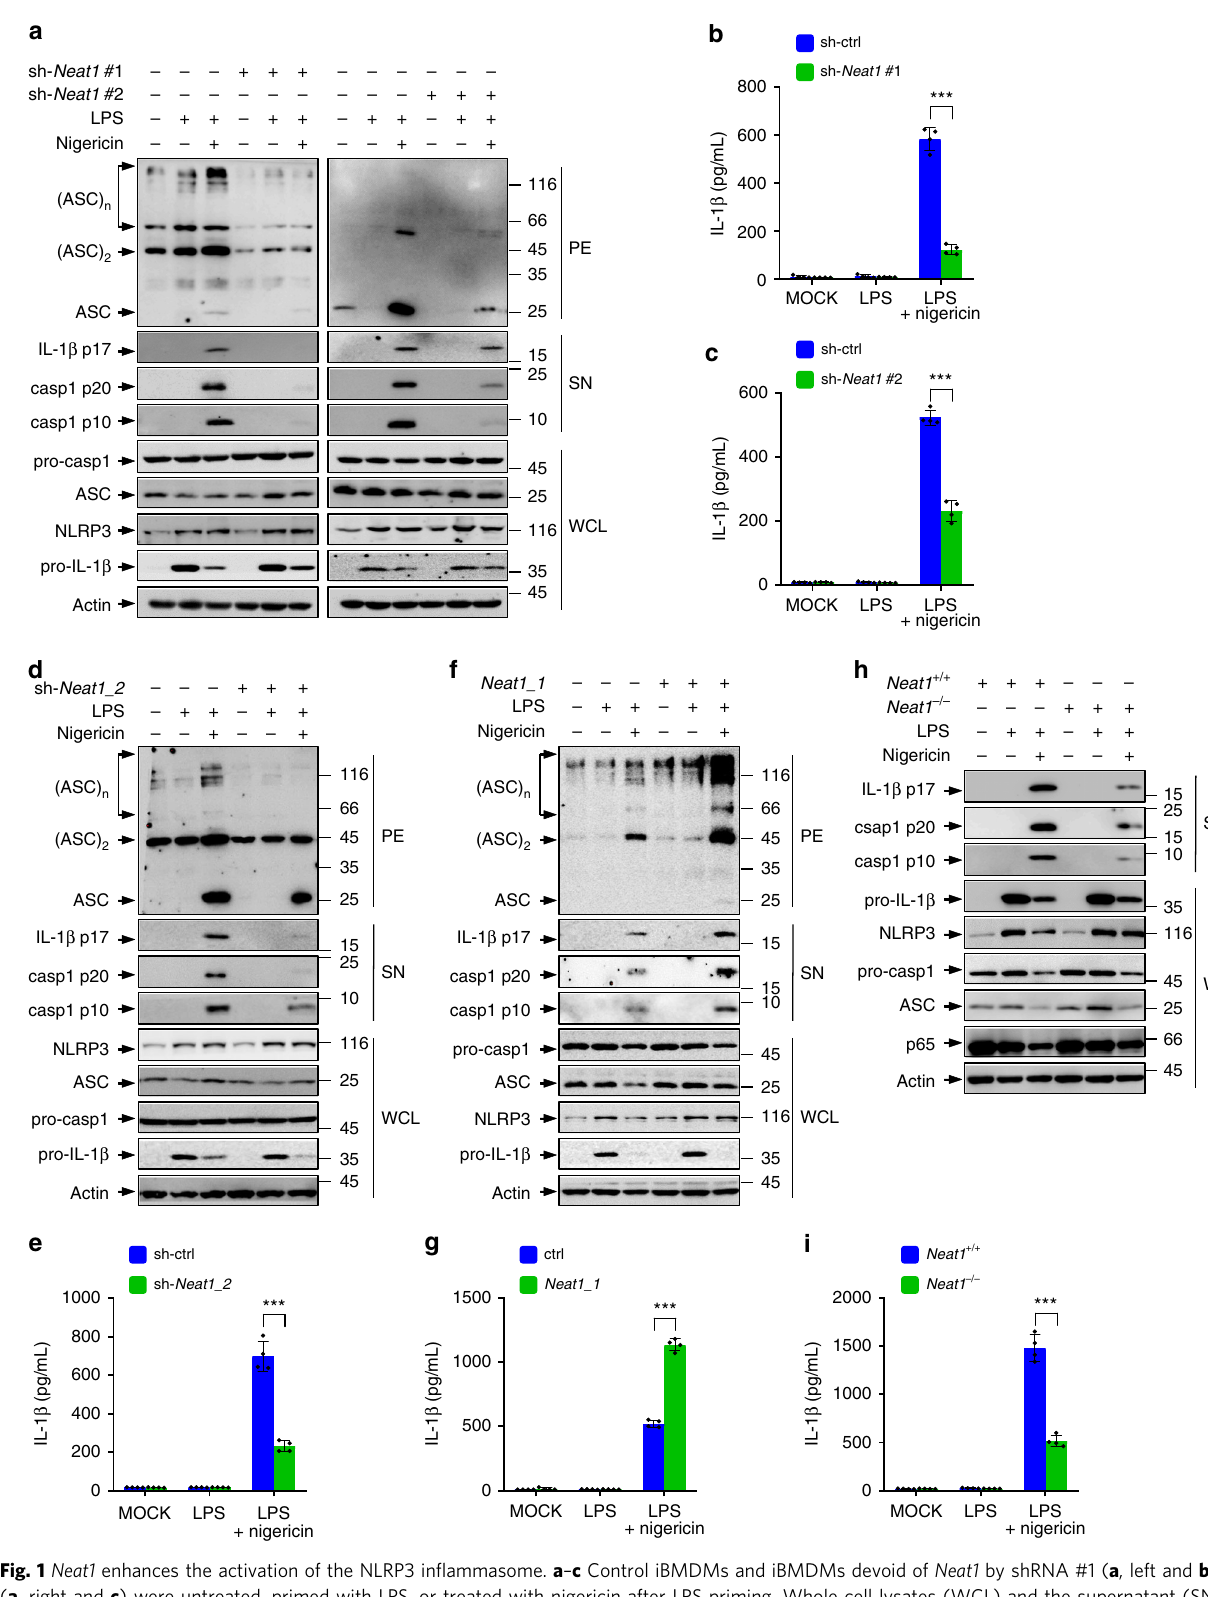
Fig. 1 Neat1 enhances the activation of the NLRP3 in fl ammasome. a – c Control iBMDMs and iBMDMs devoid of Neat1 by shRNA #1 ( a , left and b ) or #2 ( a , right and c ) were untreated, primed with LPS, or treated with nigericin after LPS priming. Whole cell lysates (WCL) and the supernatant (SN) and pellet (PE) fractions were analyzed by western blotting for indicated protein levels ( a ). Culture supernatant was analyzed by ELISA for IL-1 β secretion ( b , c ). d – g iBMDMs devoid of Neat1_2 ( d , e ) or overexpressing Neat1_1 ( f , g ) and the corresponding controls were treated with or without LPS or nigericin as indicated, and analyzed for protein levels ( d , f ) and IL-1 β secretion ( e , g ). h , i BMDMs from Neat1 wild-type ( Neat1 + / + ) or knockout ( Neat1 − / − ) mice were primed with LPS and then stimulated with nigericin as indicated. Protein levels ( h ) and IL-1 β secretion ( i ) were analyzed. In b , c , e , g , and i , data shown are mean ± SD ( n = 4). *** P < 0.001, two-tailed t -test. Source data are provided as a Source Data fi